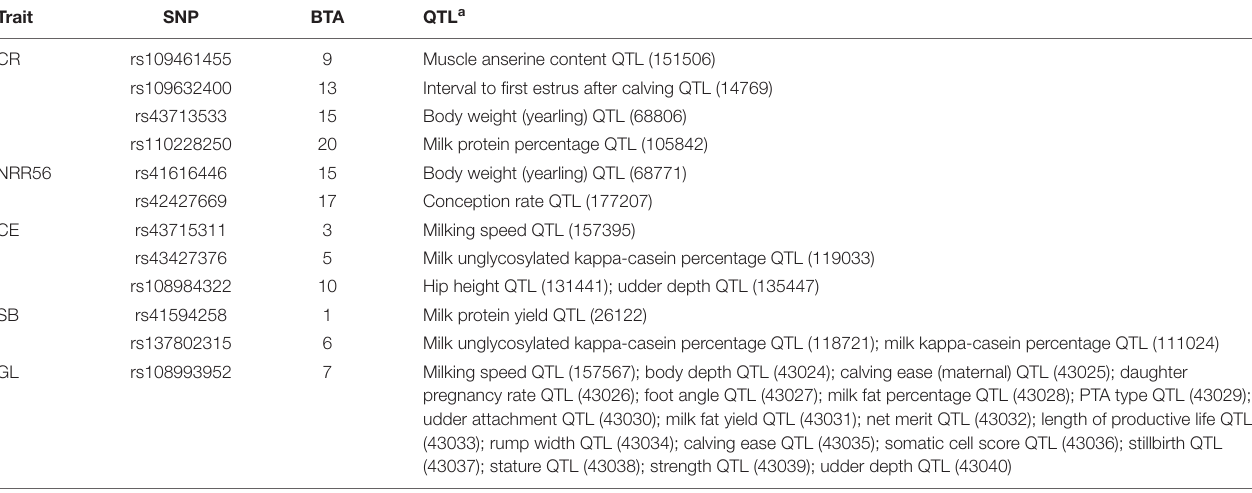
TABLE 6 | Significant single-nucleotide polymorphisms (SNPs) of the genetic effects of service sire and overlapping quantitative trait loci (QTLs). Trait